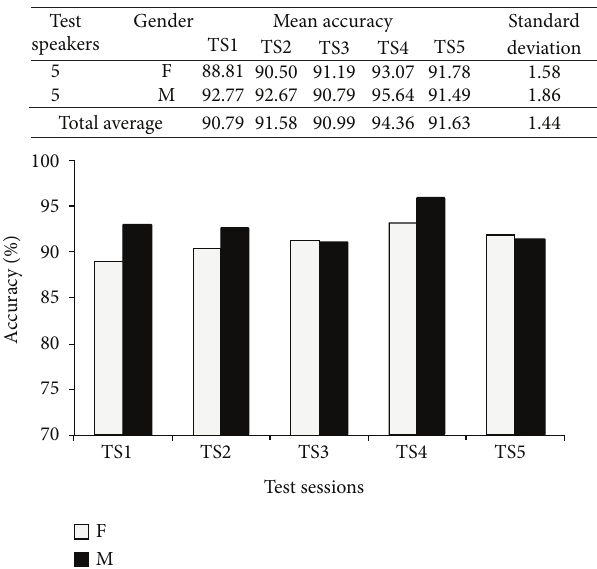
Figure 20: Accuracy of the speaker-adaptive Mexican Spanish ASR